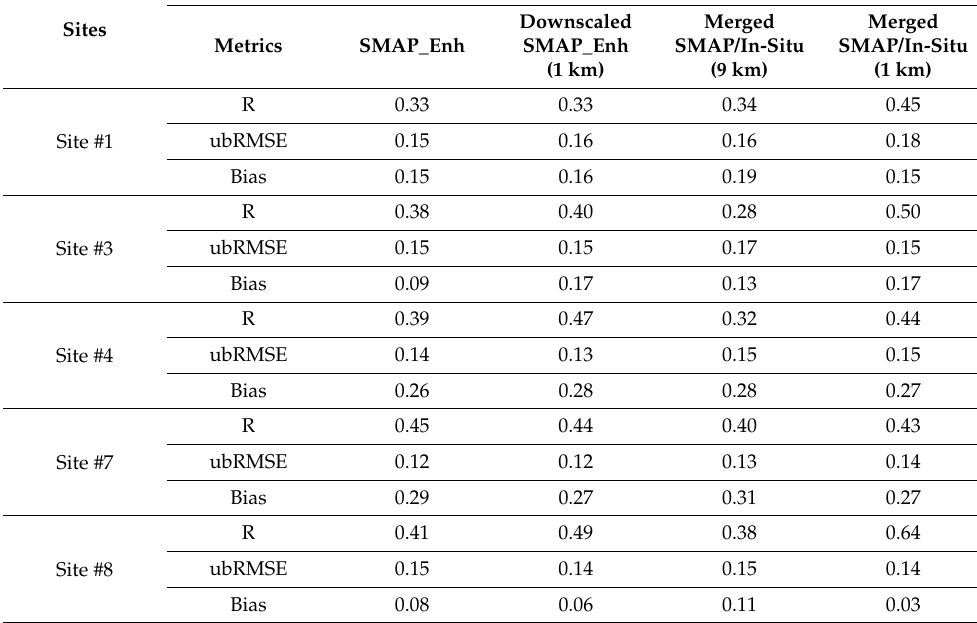
Table A1. The performance metrics for vertically extrapolated SMAP-enhanced and merged SMAP/in-situ soil